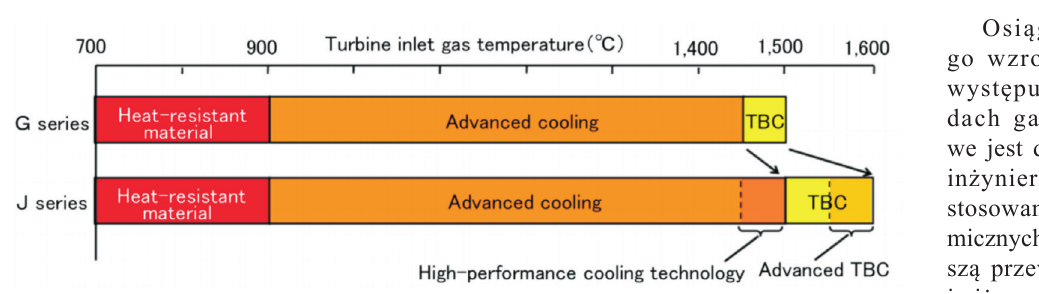
Fig. 4. Increase in temperatures upstream of the turbine with the development of the cooling technology [10]